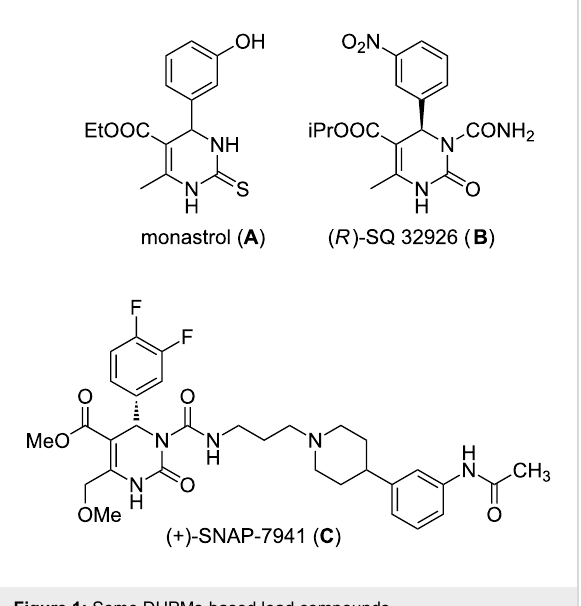
Figure 1: Some DHPMs-based lead